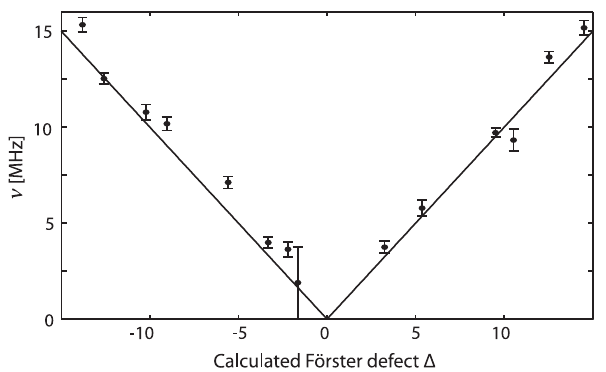
FIG. 4. Measured frequency (cid:5) of the oscillation in the visibil- ity (data points) versus the calculated Fo¨rster defect. The error bars are the standard deviation of the sinusoidal fits. The solid line shows (cid:5) ¼ j (cid:1) j